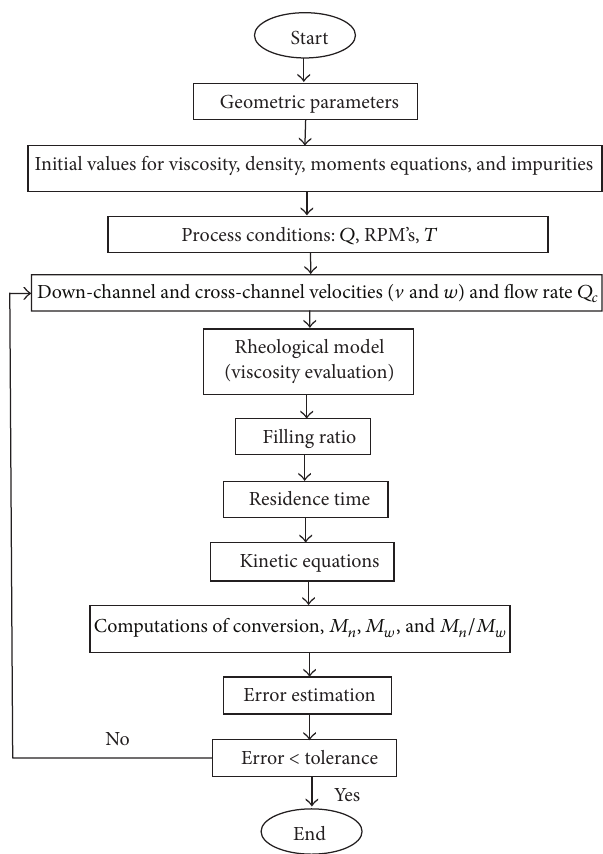
Figure 3: Flowchart of the sequence